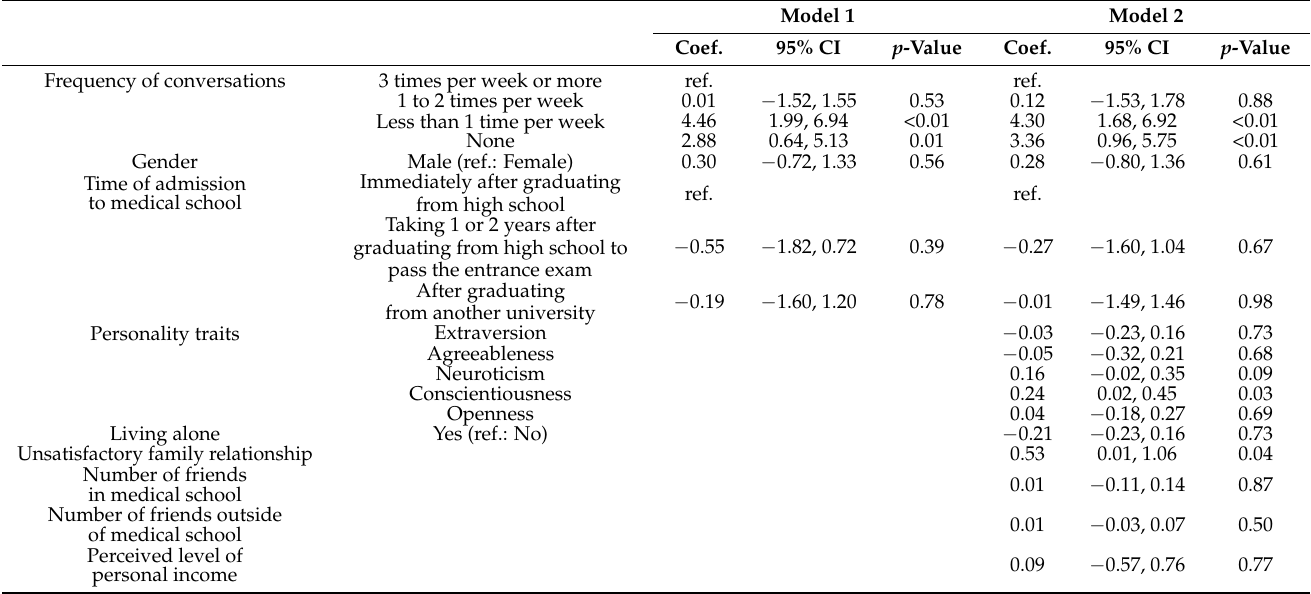
Table 3. Results of linear regression analysis about the total score for suicidal thoughts. Model 1 Model 2 Coef. 95% CI p -Value Coef. 95%